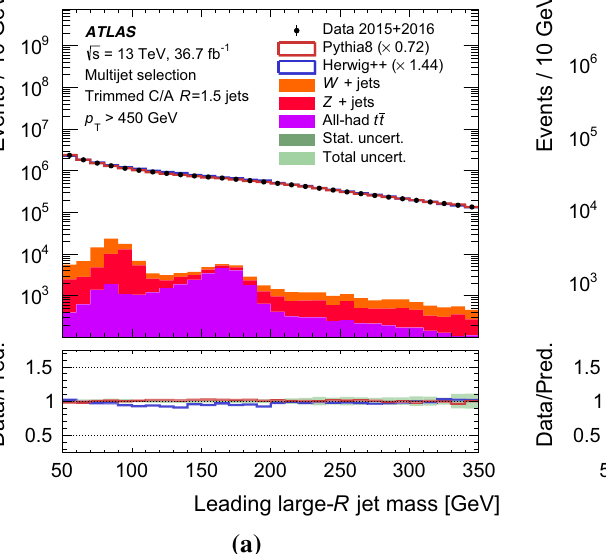
Fig. 25 A comparison of the observed data and predicted MC distri- butions of the mass of the leading p T C/A R = 1.5 trimmed jet in events for the multijet ( a ) and γ + jet ( b ) selections. The data-driven nor- malisation correction, described in Sect. 6.2.1, is shown in the legend